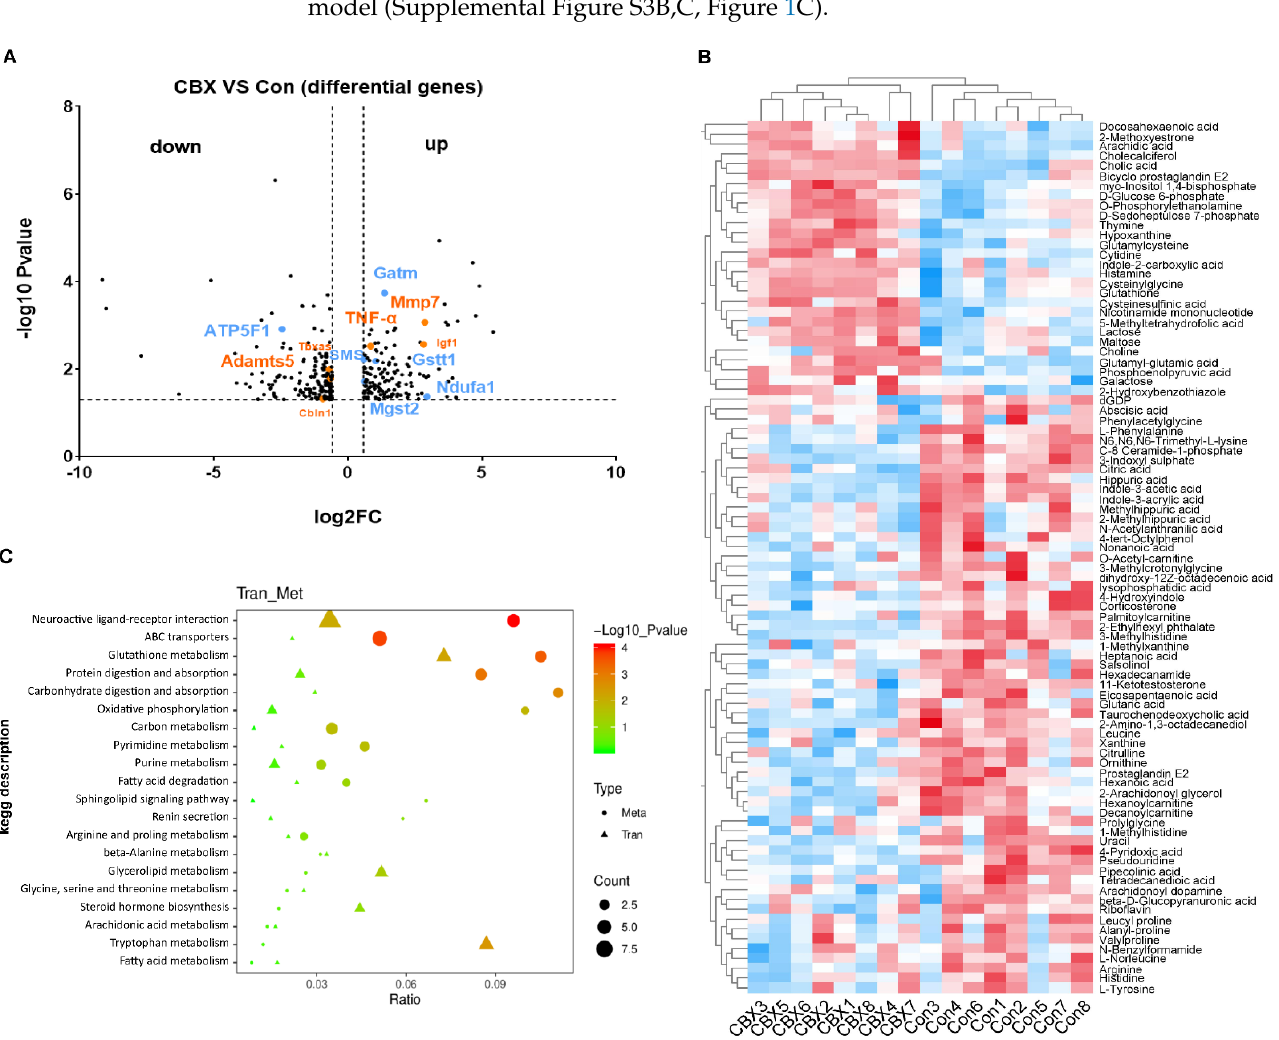
Figure 1. Transcriptomics and metabolomics of the placentas in rat PE − like model. Pregnant rats were administrated with CBX or saline from GD 7.5 to GD 17.5. The placentas were collected on GD 20.5 for RNA-seq and untargeted metabolomics. ( A ) volcano plot of differential genes in RNA-Seq between PE-like rats and controls. Orange: genes associated with PE. Blue: genes in OXPHOS, TCA cycle and glutathione metabolism. n = 5 in each group. ( B ) Cluster heat map of the differential metabolites. n = 8 in each group. ( C ) KEGG enrichment analysis combined with transcriptomics and metabolomics. Con: control. Tran: transcriptomics; Met: metabolomics.